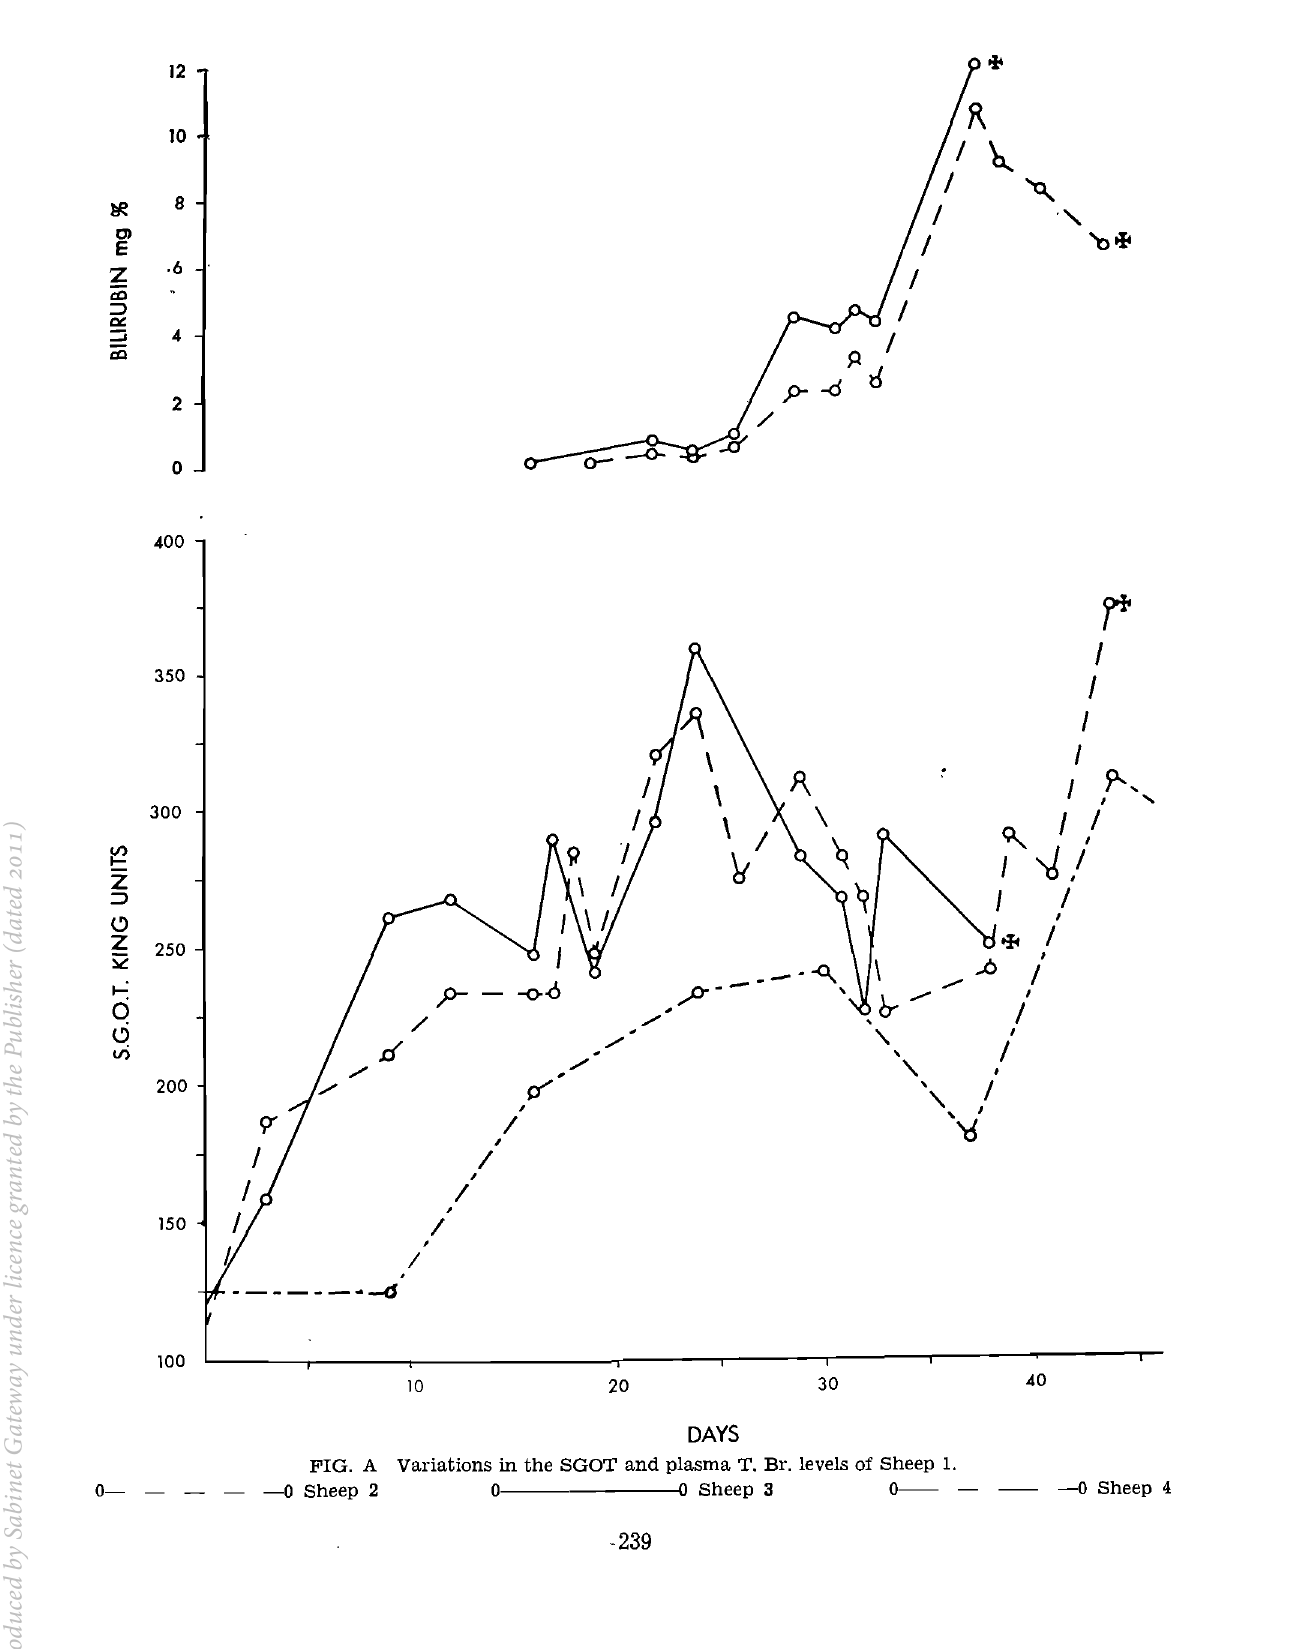
FIG. A Variations in the SGOT and plasma T. Br. levels of Sheep 1. 0-